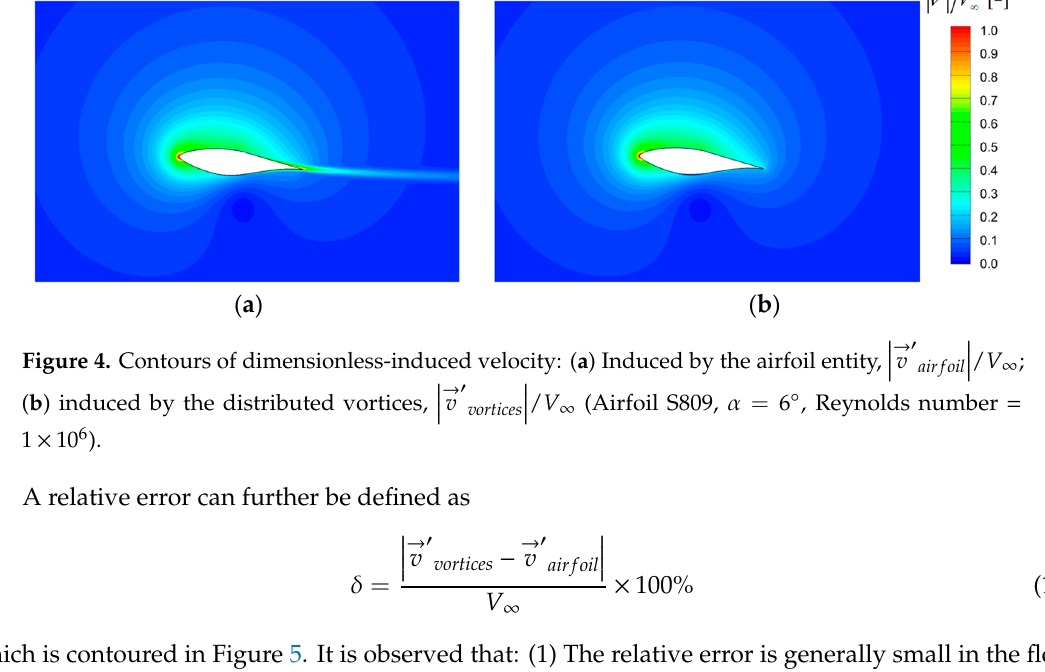
Figure 5. Contours of relative error (Airfoil S809, 6 α= ° , Reynolds number= 6 1 10 × ).